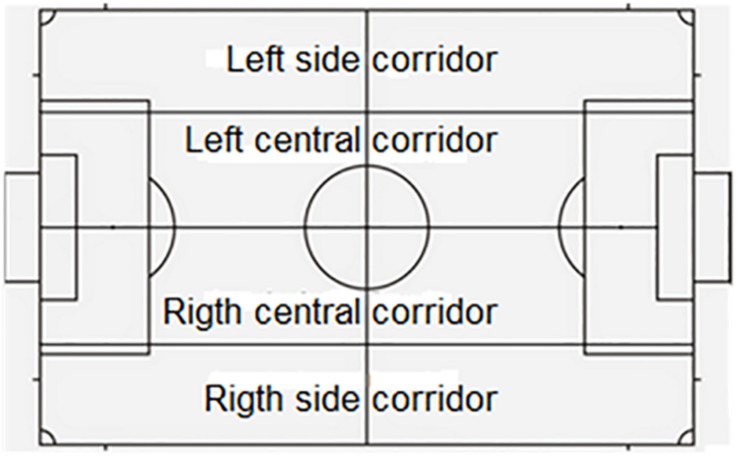
Pitch áreas. Source: Maneiro and Amatria (2018), and Maneiro et al. (2018).